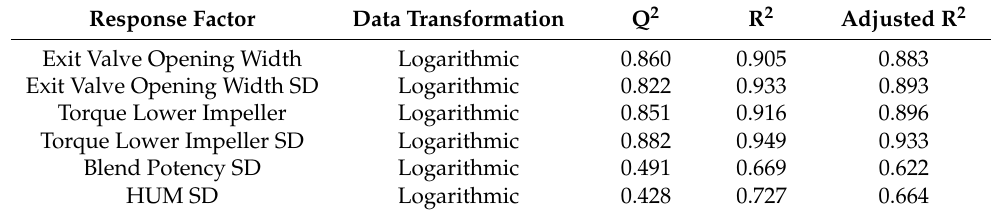
Table 6. Overview of fit statistics regarding mixing parameters after removing non-significant model terms.